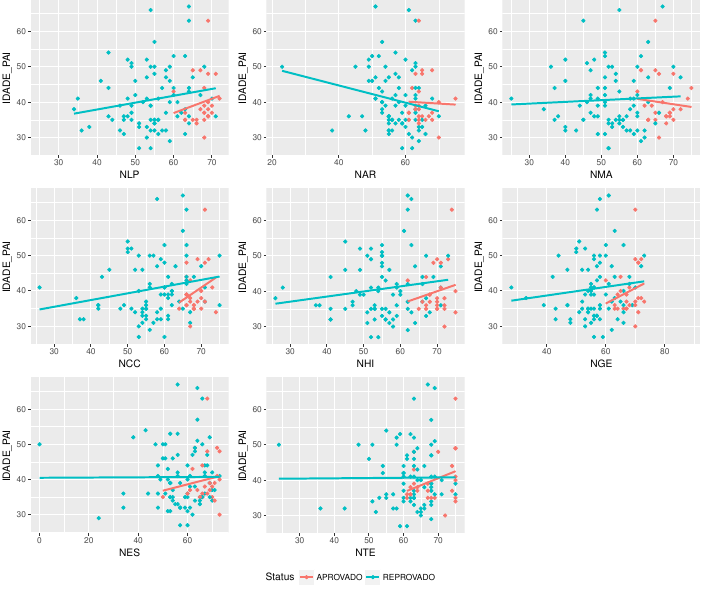
Figure 12. The correlation between discipline’s grade and father’s age.